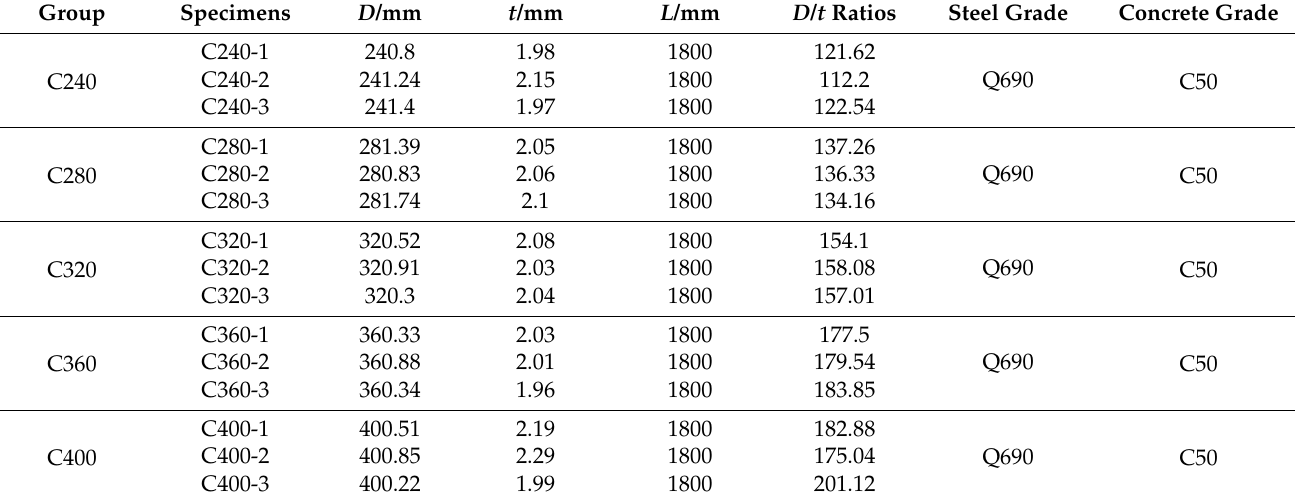
Table 1. Designed parameters of CFHST